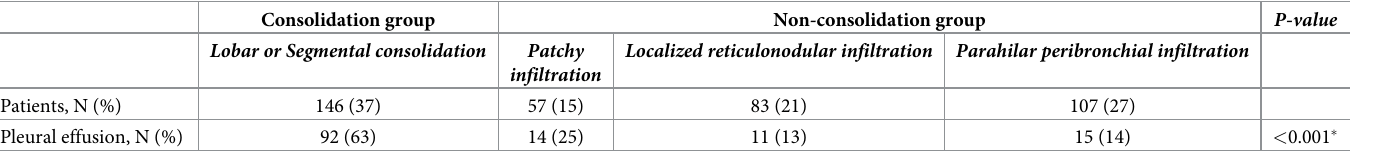
Table 1. Chest radiograph findings of Mycoplasma pneumoniae pneumonia in